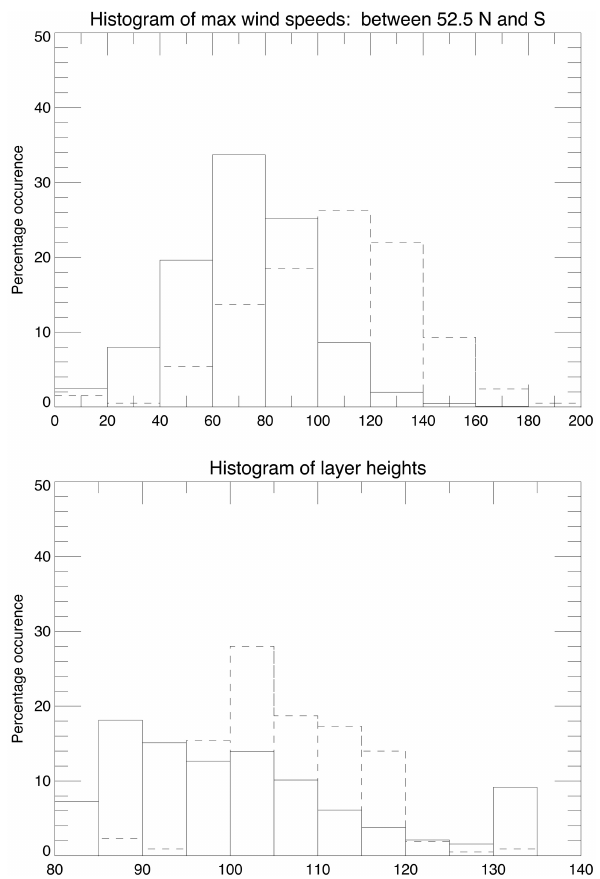
Fig. 7. Histograms of the observed winds (dashed curves) and model winds (solid curves) for the run with doubled height res- olution. The top panel shows the distribution of maximum wind speeds. The lower panel shows the distribution of heights where the maximum winds occur.